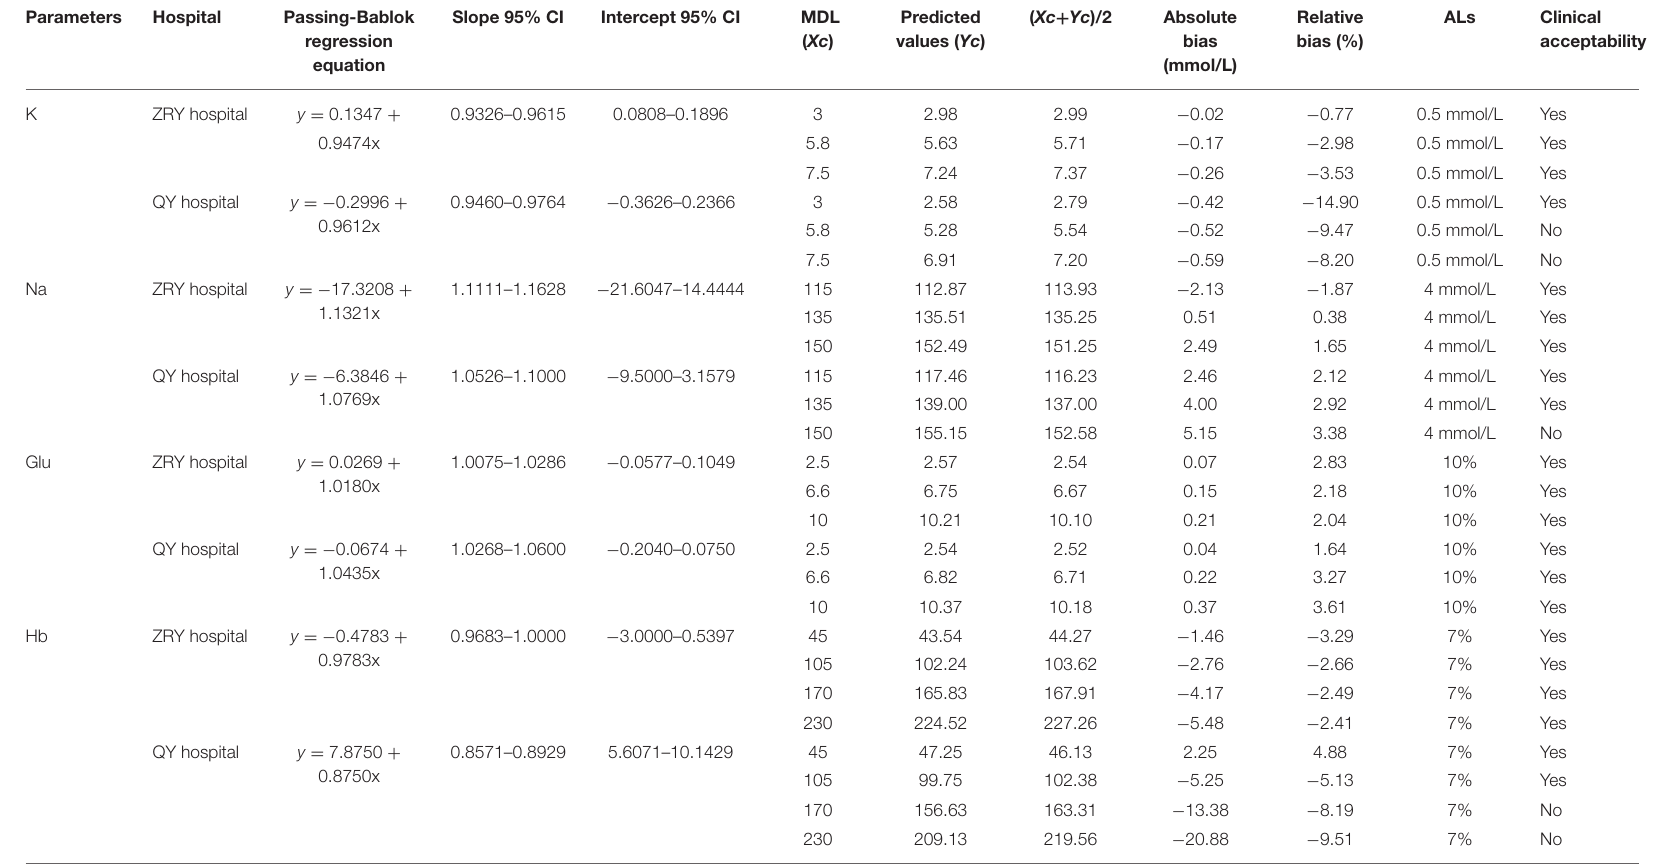
TABLE 2 | Predicted bias of potassium, sodium, glucose, and hemoglobin at a given medical decision level.